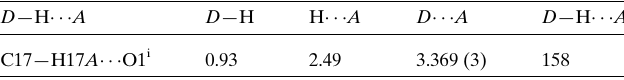
Table 1 Hydrogen-bond geometry (A˚ , (cid:3) ) for (I). Cg 1 is the centroid of the C18–C23 ring.